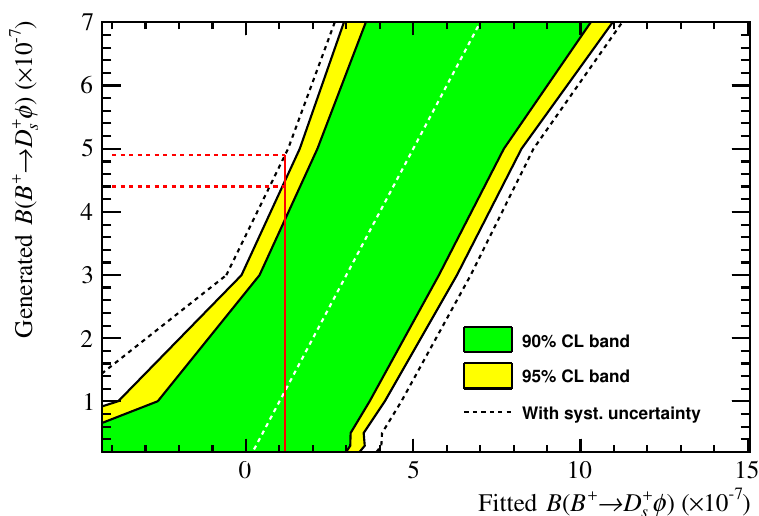
Figure 6. Con(cid:12)dence bands produced using the Feldman-Cousins approach. The green and yellow bands represent the statistical-only 90% and 95% CL bands. The black dotted line represents the 95% limit including systematic uncertainties. The measured value of the branching fraction is shown by the vertical red line, and the corresponding 95% CL limits, with and without systematic uncertainties, are represented by the dotted red